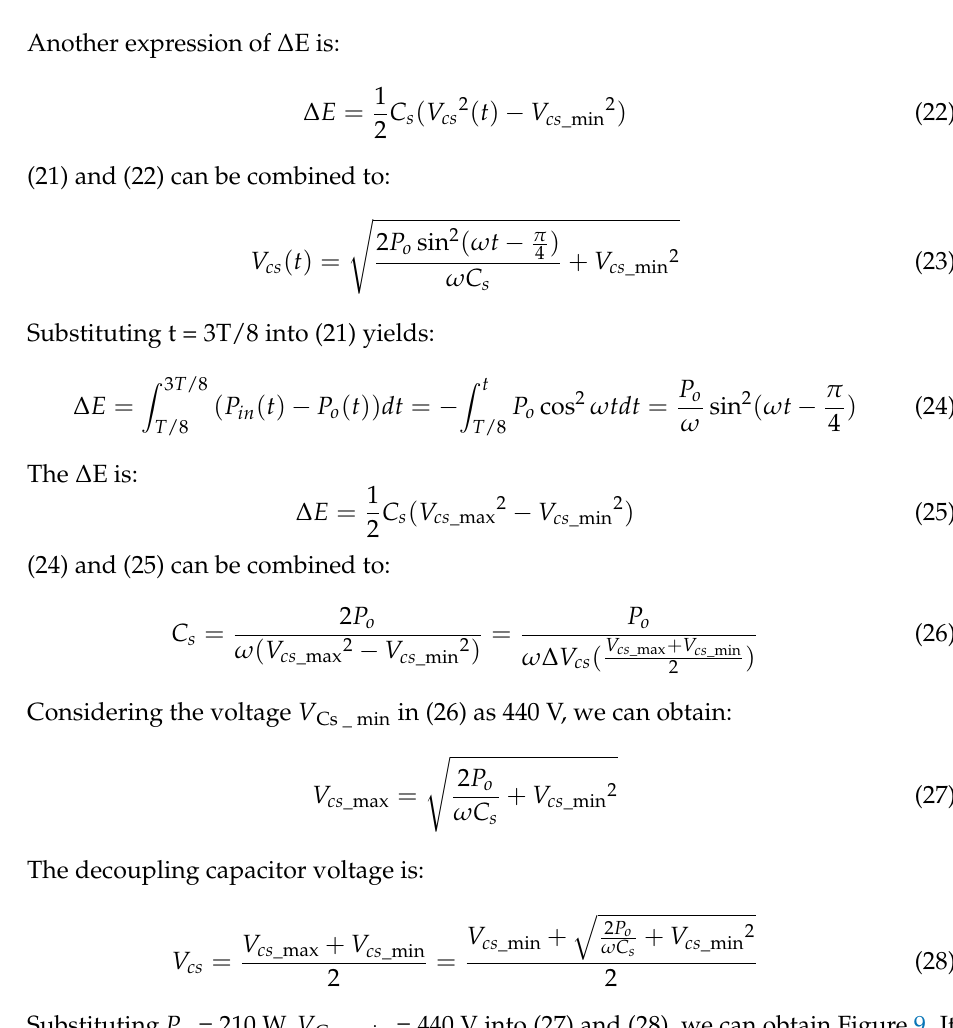
Figure 8. Waveforms of V in 、 i in 、 P in 、 P o 、 V cs .